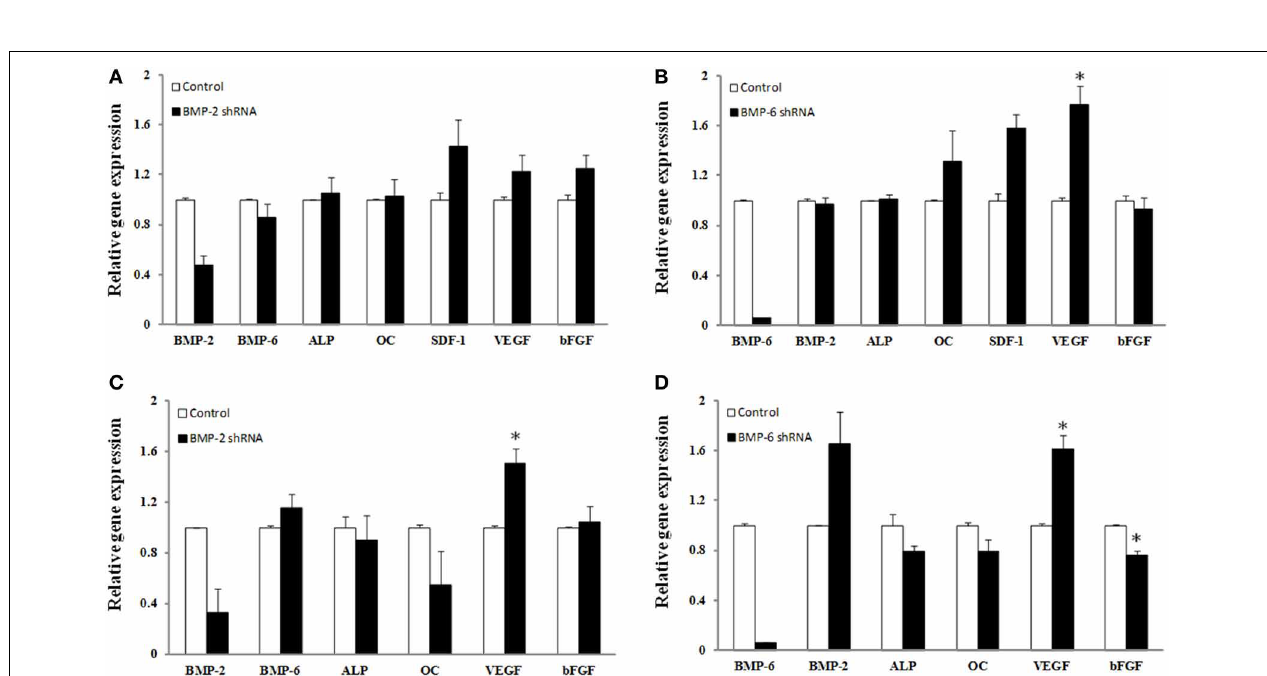
FIGURE 3 | Effect of different BMPs on SDF-1 (A), VEGF (B), and b-FGF (C). BMSCs were treated with BMP-2,- 4,-5, -6, -7, or -9 for 3 days, and the supernatant collected for ELISA on the third day. The bar graph represents the mean ELISA value normalized to cell number and is